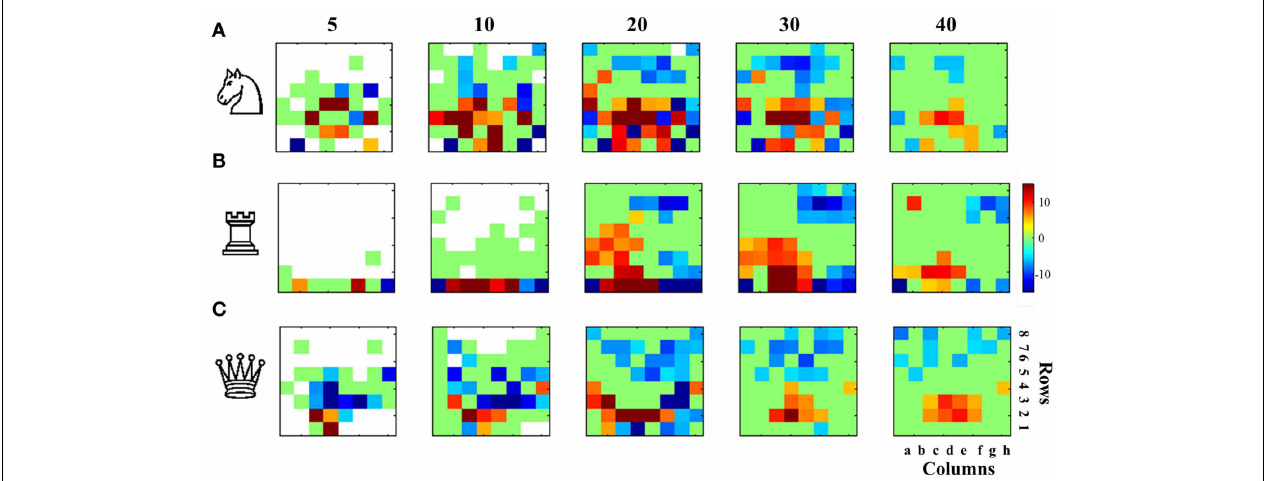
FIGURE 3 | Piece distribution over the board reveals domain-specific and expertise-dependent strategies. Probabilities to find a type of piece (normalized by the number of remaining pieces of this type) in each square (8 ∗ 8 checkerboard) were compared for high and low expertise groups at different game stages (moves 5, 10, 20, 30, and 40). The t -value resulting of the two-sample t -test (high vs. low expertise group), in each square is color coded for those significantly different comparisons with p < 0 . 001 Bonferroni corrected for multiple comparisons. Red positive values indicate significantly higher probabilities for strong players and blue negative values, significantly